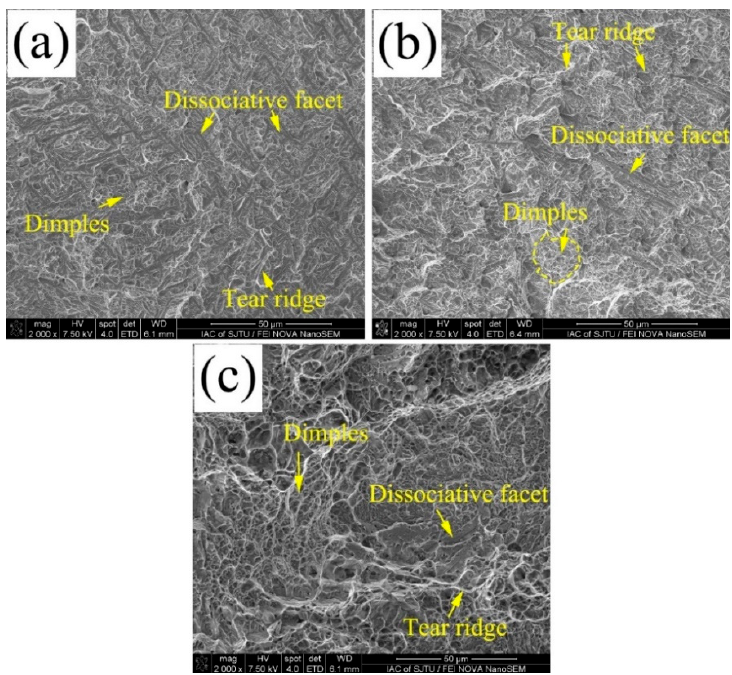
Figure 12. Mechanical properties of the laser cladded bainitic coatings.